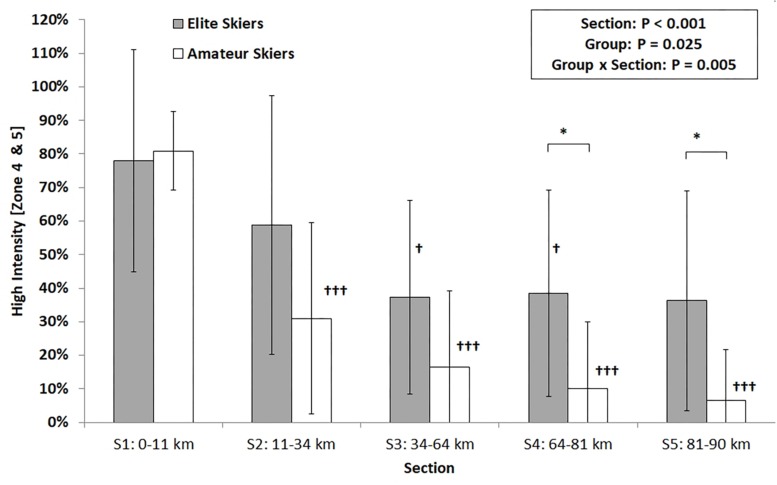
Proportion of high intensity (zones 4 and 5) within the five sections of the 90-km Vasaloppet race for elite and amateur skiers. *P < 0.05, significantly different to amateur skiers; †, †††P < 0.05, P < 0.001, significantly different to section 1.